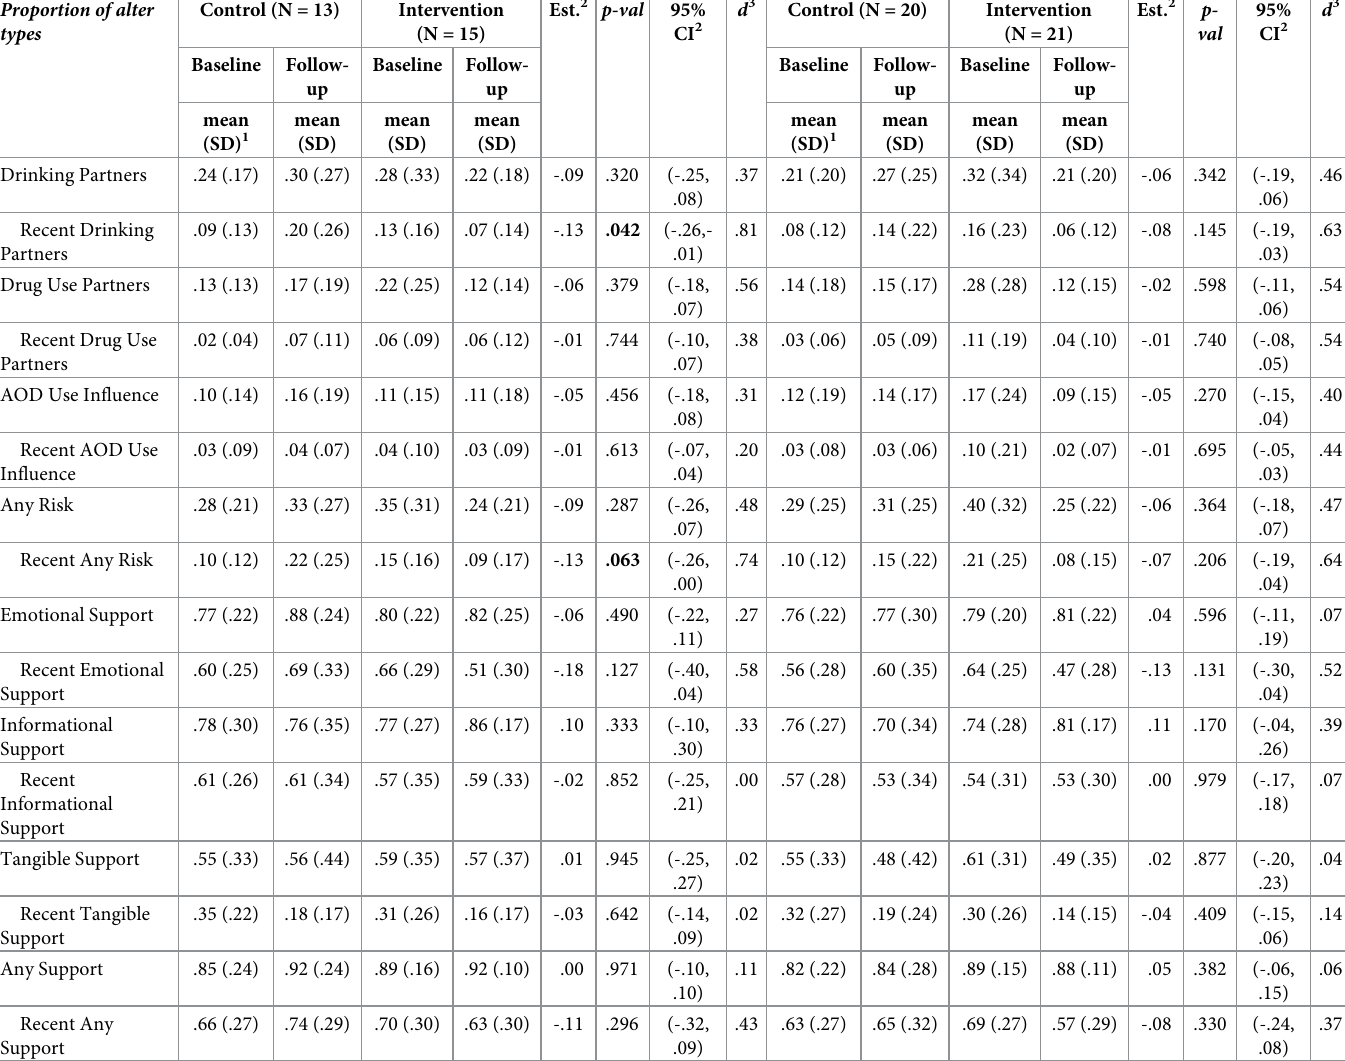
Table 1. a. Regression model results for intervention effects on personal network composition, SRHT only (N = 28). b. Regression model results for intervention effects on personal network composition for full sample (N = 41). Proportion of alter